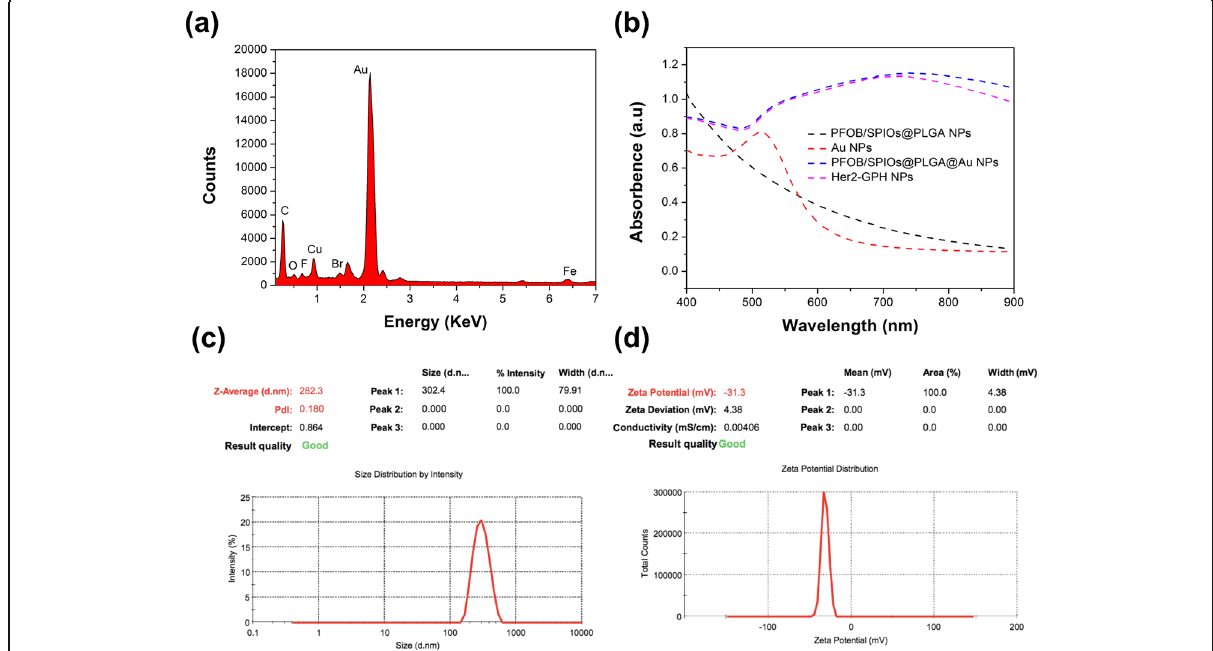
Fig. 3 Characterizations of Her2-GPH NPs. a EDS elements analysis of Her2-GPH NPs; b UV – Vis absorption spectra of Her2-GPH NPs at different preparation stages; c Size distribution and d Zeta potential of Her2-GPH